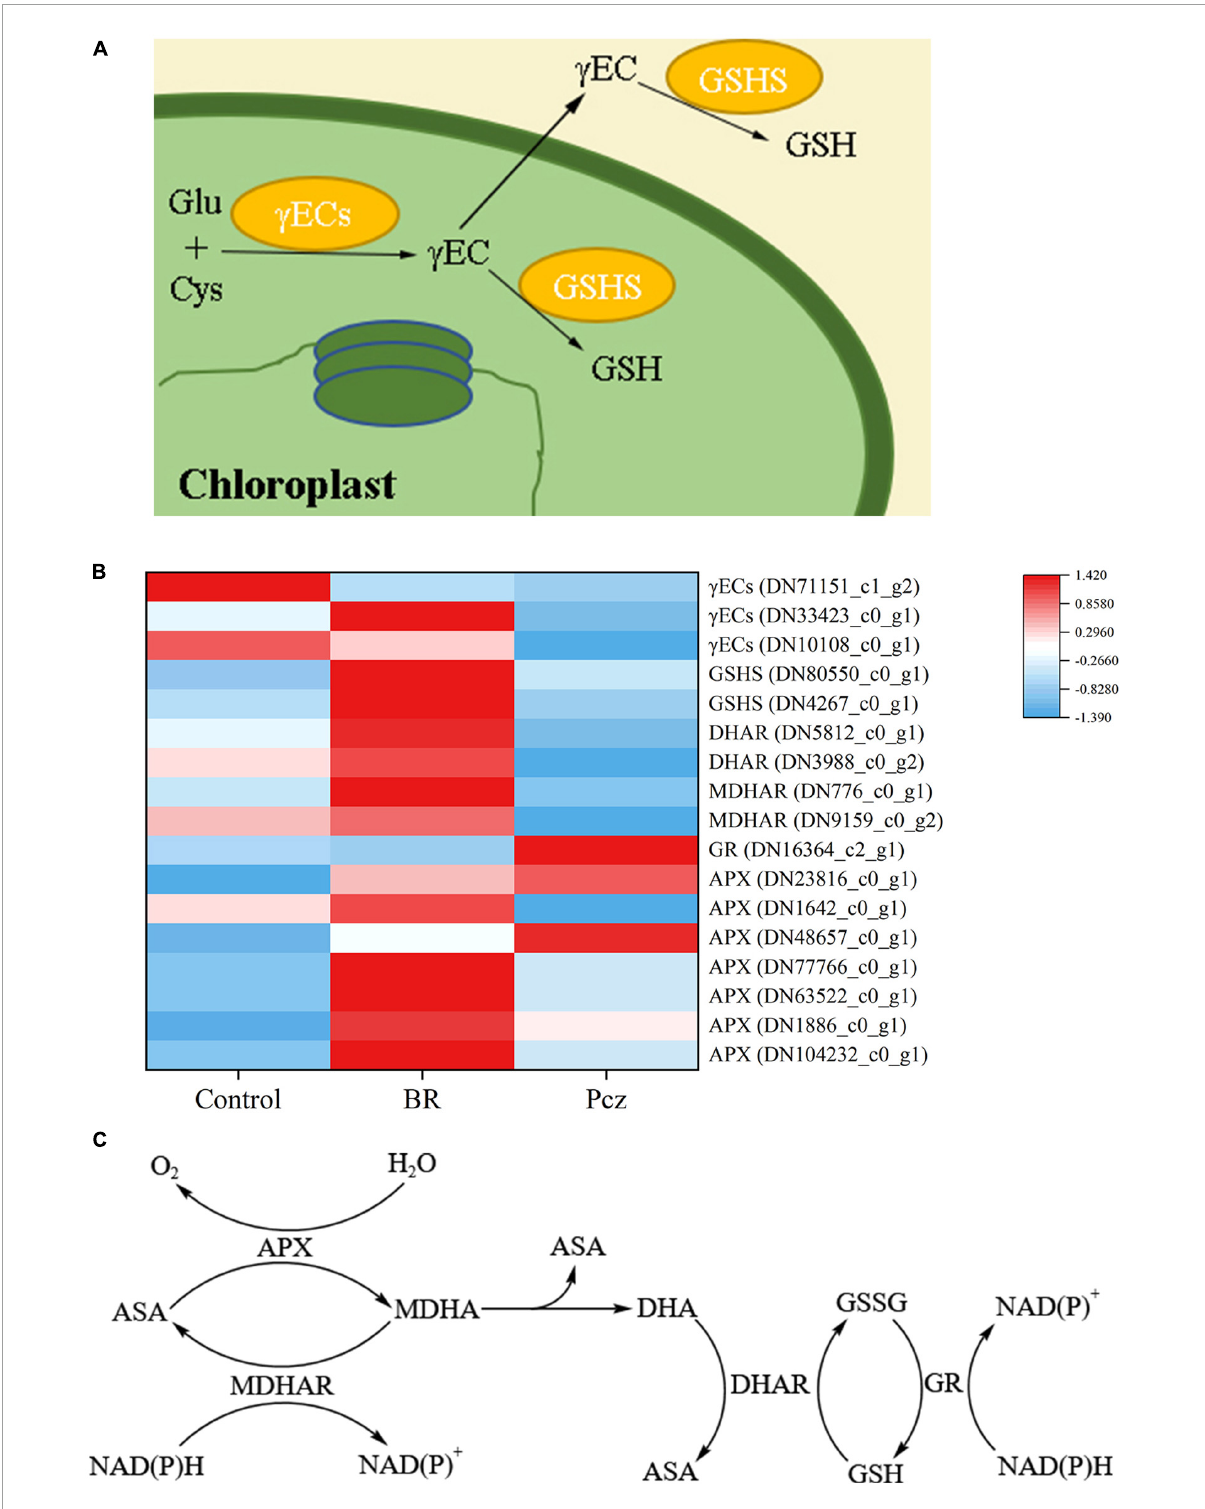
FIGURE9 Analysis of differentially expressed levels related to glutathione and Ascorbate–Glutathione pathway in bulbil of P. ternata under BR and Pcz treatments. (A) , the glutathione biosynthetic pathway. (B) , the expression levels of genes related to the glutathione and Ascorbate-Glutathione pathway. (C) , the Ascorbate–Glutathione pathway. Blue indicates a lower expression level, whereas red indicates a higher expression level. All the data showed the average mean of three biological